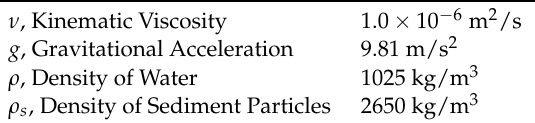
Table 1. Typical constants.